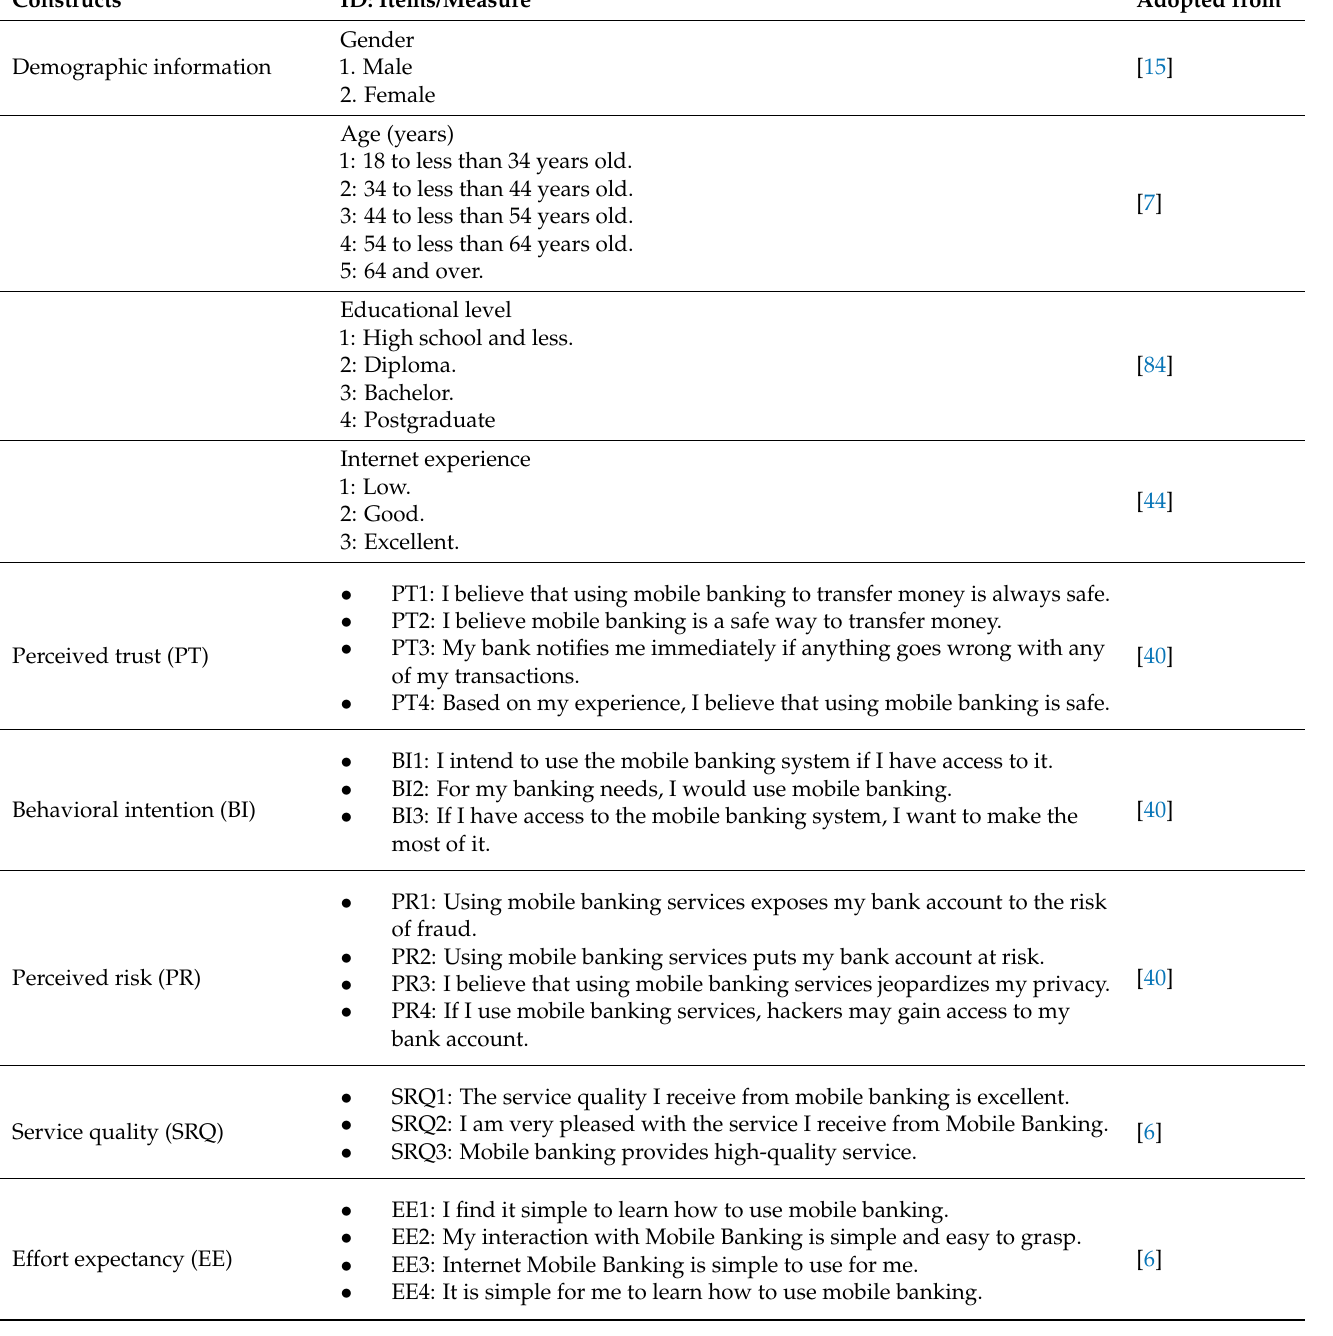
Table A1. The constructs and their measures with each original